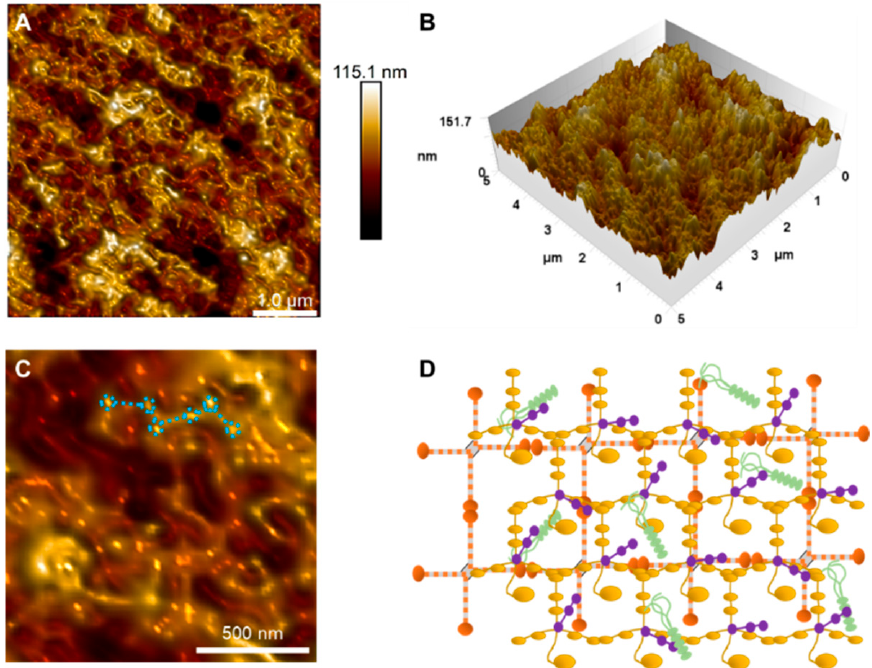
Figure 3. Topographic map of the basement membrane surface obtained using AFM. ( A ) Two- dimensional map of the scanning area of 5 × 5 µ m and ( B ) its three-dimensional visualization. ( C ) Magnification shows the globular and linear ultrastructures on the basement membrane’s surface, indicated by blue dotted lines. ( D ) Schematic representation of the basement membrane in which the general molecular matrix led to this layer’s texture due to interactions between the main individual